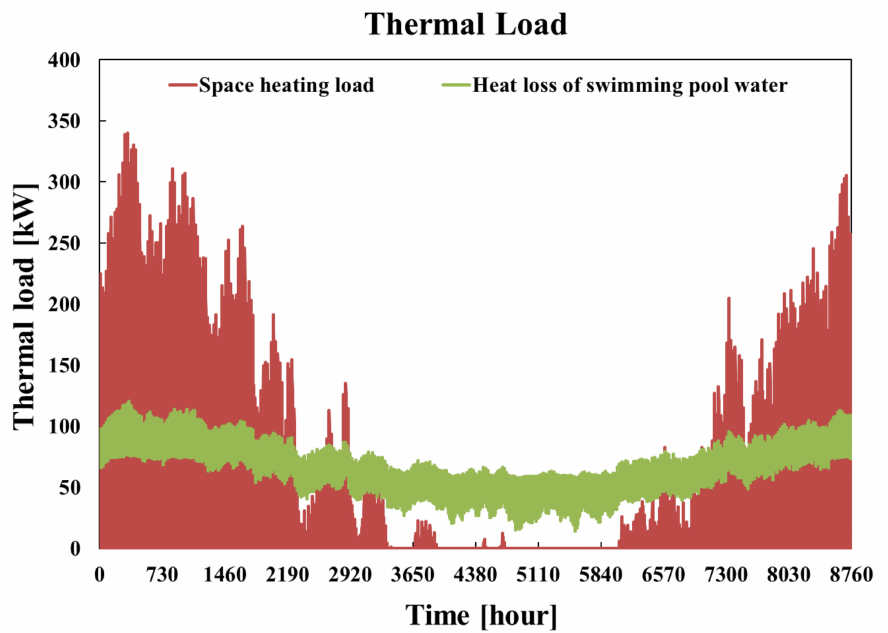
Figure 9. Building space heating load and swimming pool heat loss evaluated by the TRNSYS